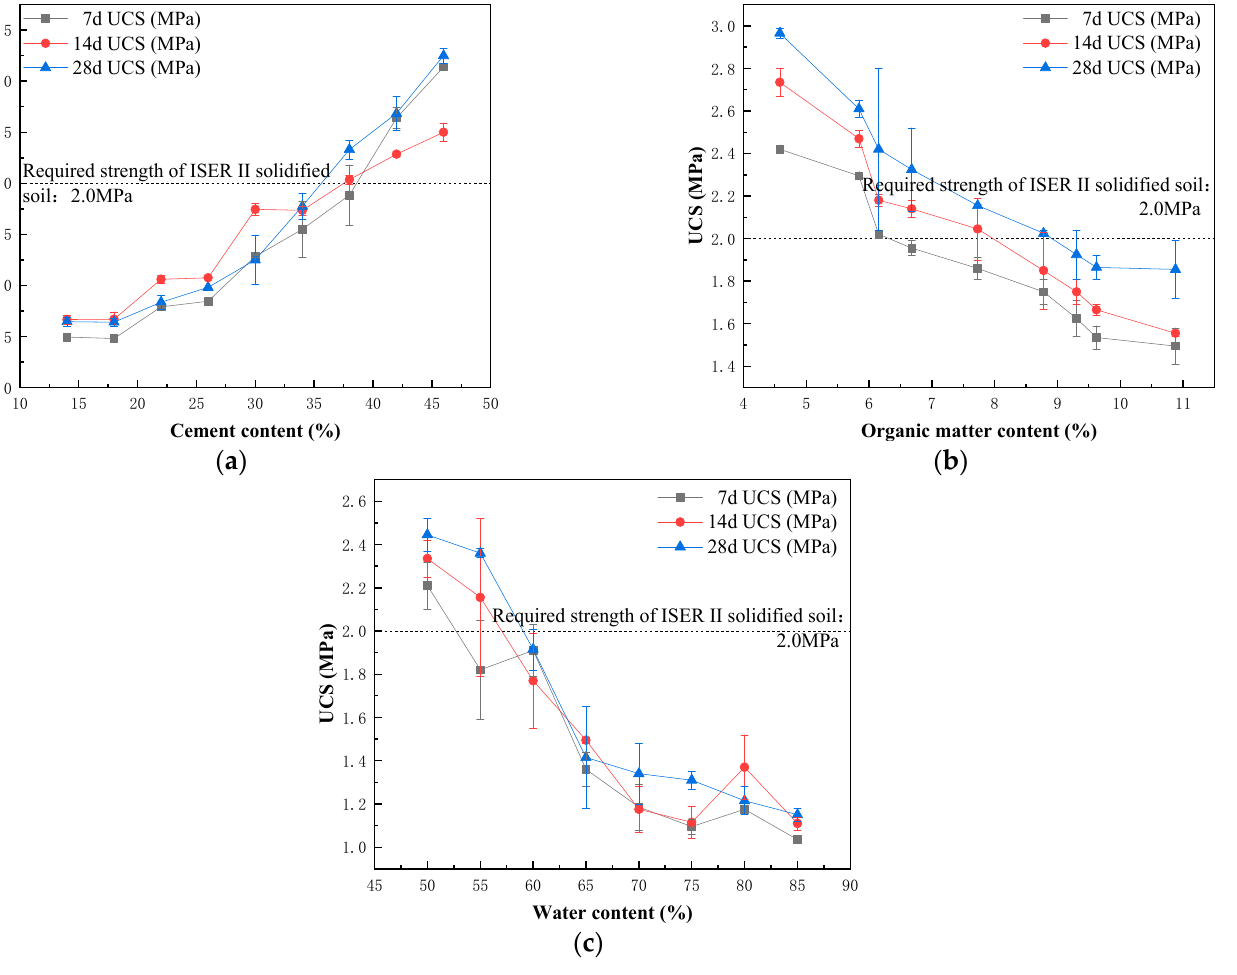
Figure 1. ( a ) Compressive strength of solidified block with different cement contents; ( b ) Compressive strength of solidified block with different organic matter contents; and ( c ) Compressive strength of solidified block with different water contents.